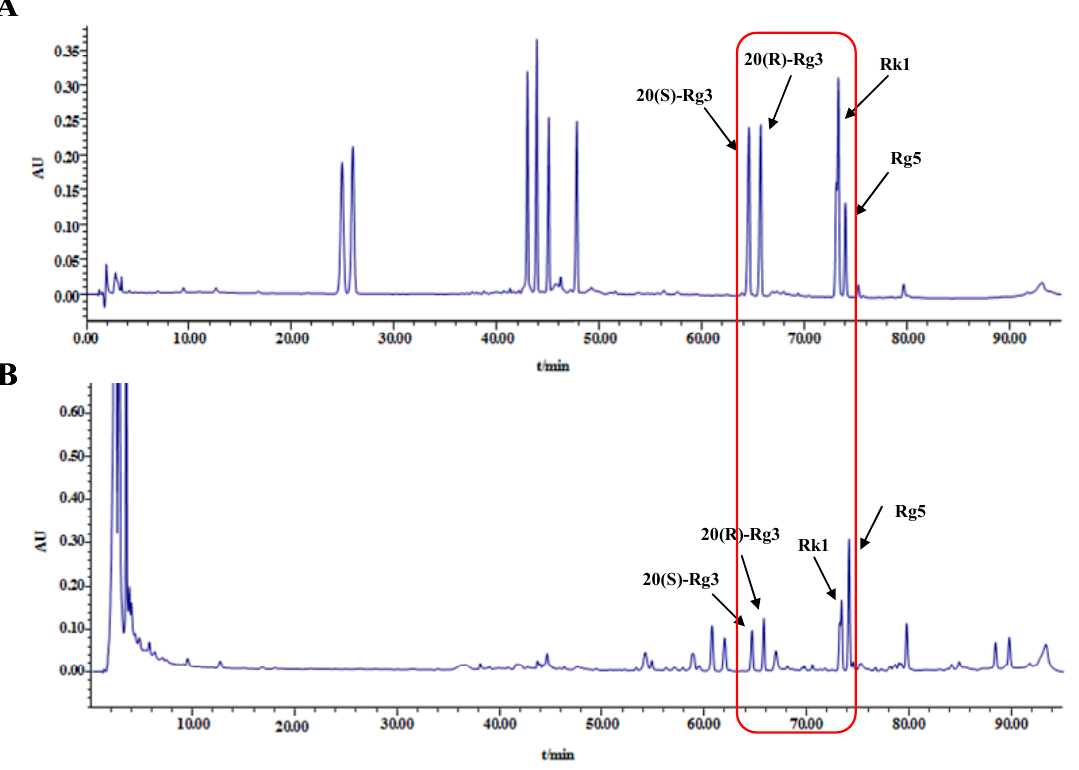
Figure 1. HPLC chromatogram of ginsenosides in mixed standard compounds ( A ) and Black ginseng ( B ).